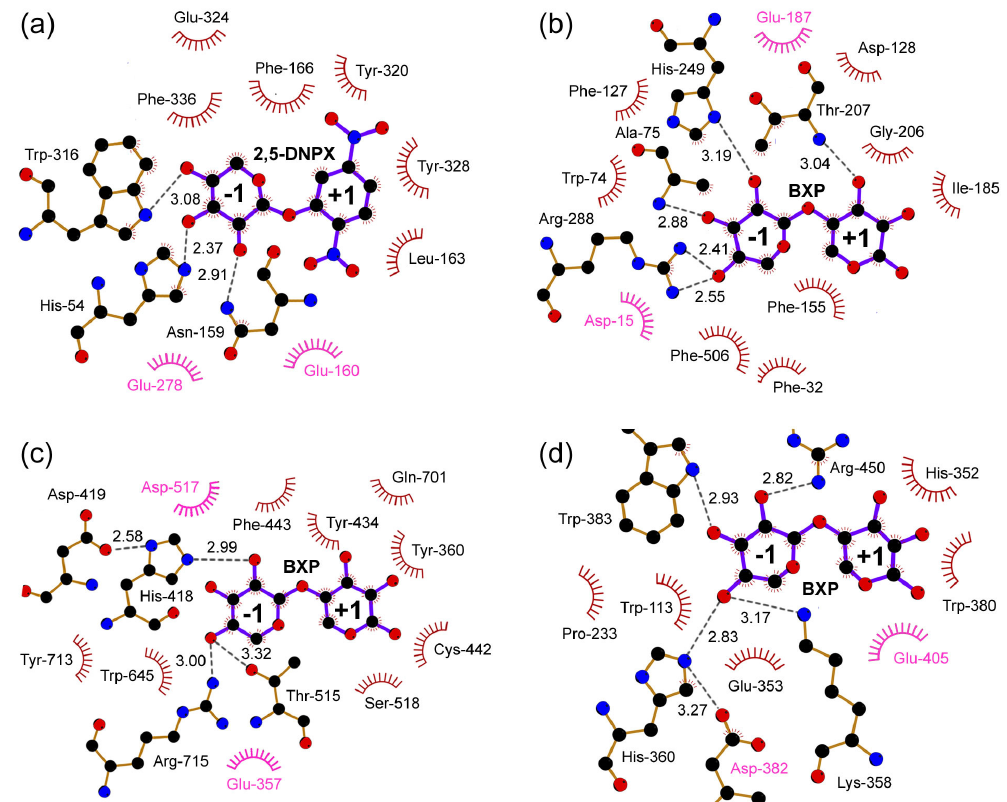
Figure 4. Interactions between active site residues of β -xylosidases and their ligands. The ligands 2,5-DNPX (2,5-dinitrophenyl- β - d -xyloside) and BXP ( β - d -xylobiopyranose) are represented with purple bonds and their binding subsites -1 and + 1 are indicated. Catalytic residues are labeled in magenta. Hydrogen bonds are shown as dashed lines and their distances are indicated in Å, while hydrophobic interactions are rendered with arcs. The active sites are of ( a ) GsXynB1 (PDB 2bfg); ( b ) GsXynB3 (PDB 2exj); ( c ) GT2_24_00240 (PDB 4c1p); and ( d ) TsXylC (PDB 3vsu), which represent β -xylosidases from GH families 39, 43, 52, and 120, respectively (see caption of Figure 3 for further details of the enzymes). Interaction analysis and figure preparation were performed using LigPlot + [77].